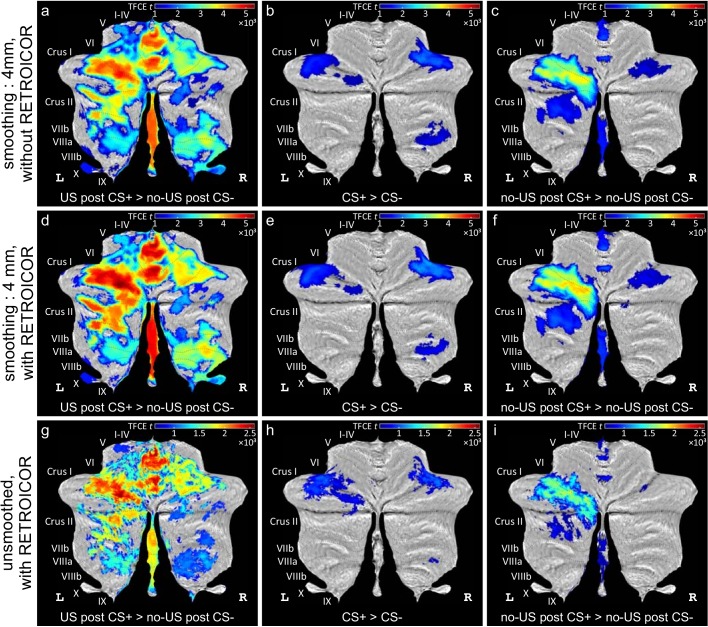
Effect of physiological denoising and smoothing kernel.Differential cerebellar activations during fear acquisition (p<0.05 FWE corrected, TFCE) in SUIT space projected on a cerebellar flatmap (Diedrichsen and Zotow, 2015): following application of (a–c) a 4 mm smoothing kernel on the normalized functional images and without use of RETROICOR physiological denoising, (d–f) 4 mm smoothing kernel and physiological denoising, and (g–i) physiological denoising but without any smoothing. Note that data displayed in (d–f) are identical to data shown in Figure 3a–c of the main manuscript. For comparability, data overlays in (a–f) are scaled to the range of the overall minimal to maximal value. Cerebellar activation patterns were essentially unchanged. Physiological denoising and spatial smoothing, however, improved statistical power. CS = conditioned stimulus; FWE = familywise error; L = left, R = right; TFCE = threshold-free cluster-enhancement; US = unconditioned stimulus.